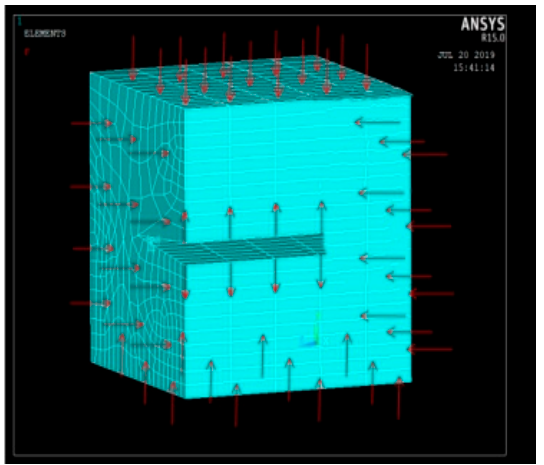
Figure 9. Mechanical model of cold loading of the coal sample with circulating liquid nitrogen.